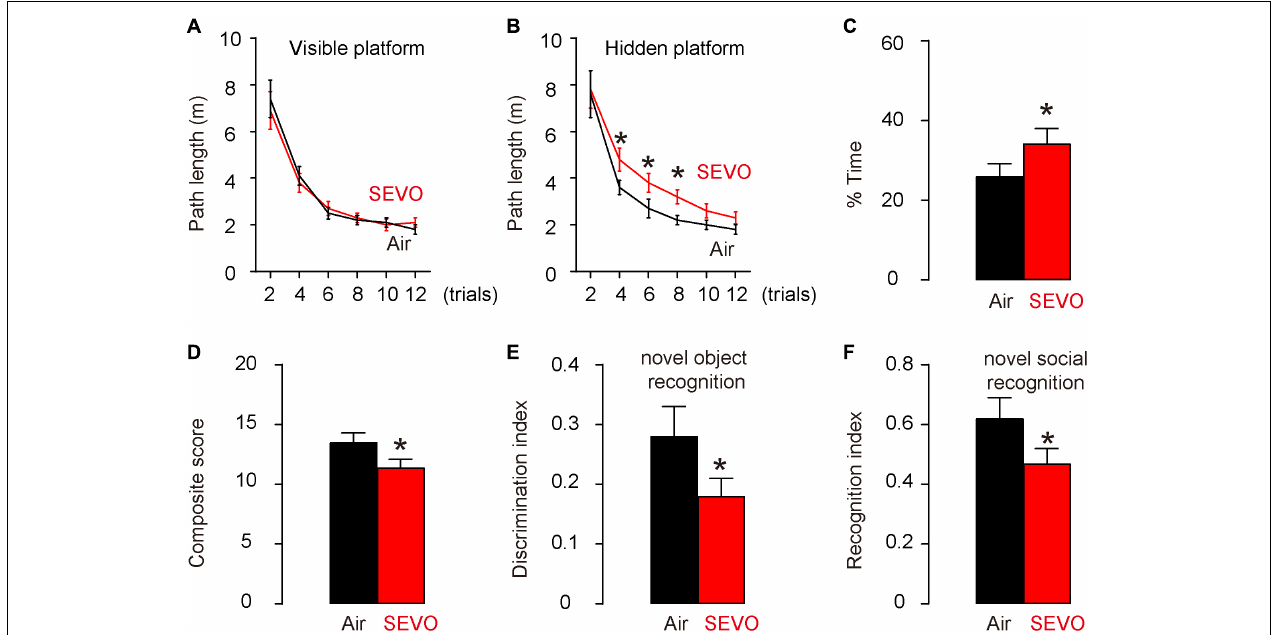
FIGURE 1 | SEVO impairs spatial reference memory, sensorimotor, and cognitive function of AD-prone mice. AD-prone APP/PS1 mice, 3 months of age, were randomly selected into two groups of 10 each. The SEVO group was exposed to 5% SEVO for 8 h, while the control group was exposed to normal air (Air). Afterward, the mice were kept for another 2 months before assessment of their behavioral changes. (A–C) Morris water maze test for assessing spatial reference memory. (A) Path length in the visible platform phase. (B) Path length in the hidden platform phase. (C) Target quadrant occupancy. (D–F) Sensorimotor and cognitive test. (D) Composite score. (E) Novel object recognition task. (F) Novel social recognition task. * p < 0.05. N = 10. N represents mouse number per experimental